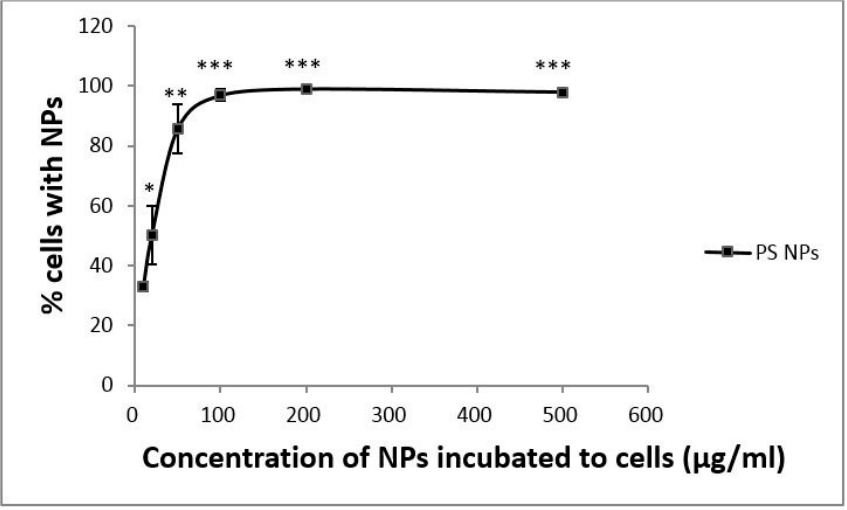
Figure 1. Dose dependency of PS NP cellular uptake by A431 cells. A431 cells were treated with different concentrations of PS NPs (10, 20, 50, 100, 200 and 500 µg/mL) at 37 °C for 24 h. The cellular uptake efficiency of NPs was normalized to that of untreated control cells. Mean values ± standard deviation, n = 3. * p ≤ 0.05, ** p ≤ 0.01, *** p ≤ 0.001 compared to each normalized control.